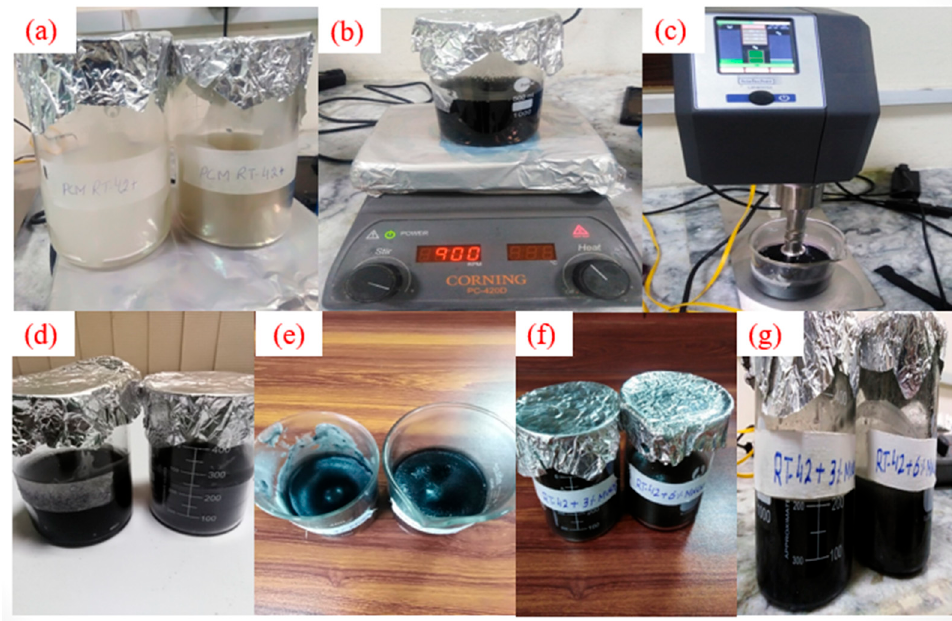
Figure 5. ( a ) RT-42 PCM heating, ( b ) magnetic stirring, ( c ) sonication, ( d ) prepared nanofluids, ( e ) NePCM after 24 h, ( f ) NePCM after 3 days, and ( g ) NePCM after 10 days.